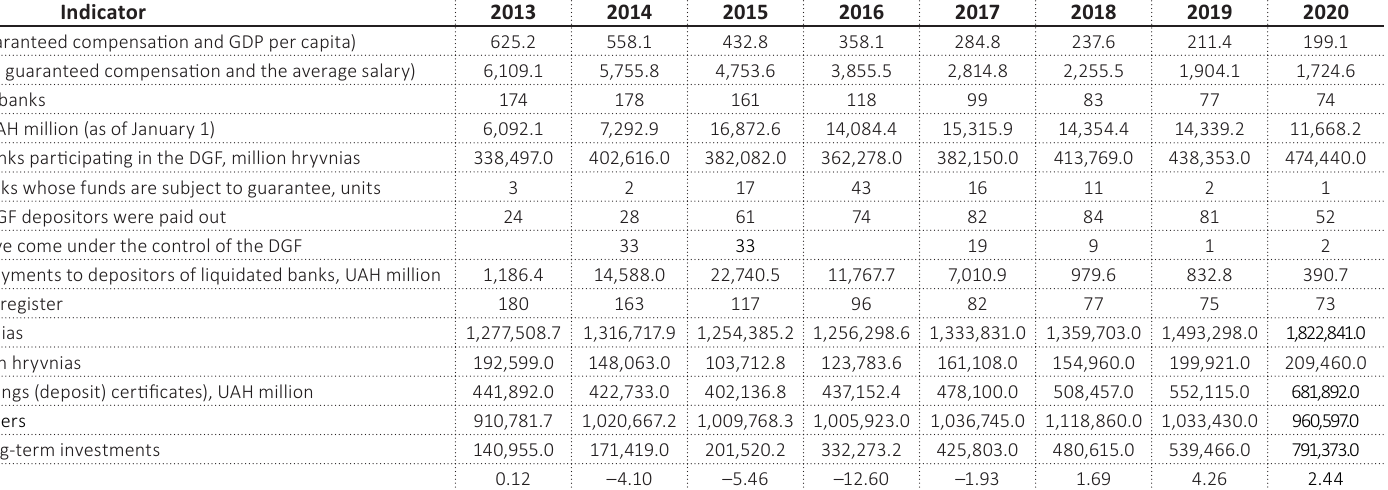
Table А2. Deposit insurance indicators in Ukraine in 2013–2020